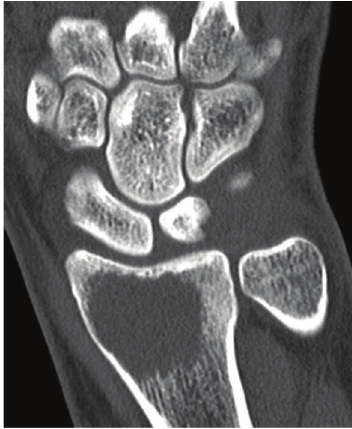
Figure 4: Computed tomography of the right wrist (coronal section): the extension of the lytic lesion in the subchondral region of the distal radius is well